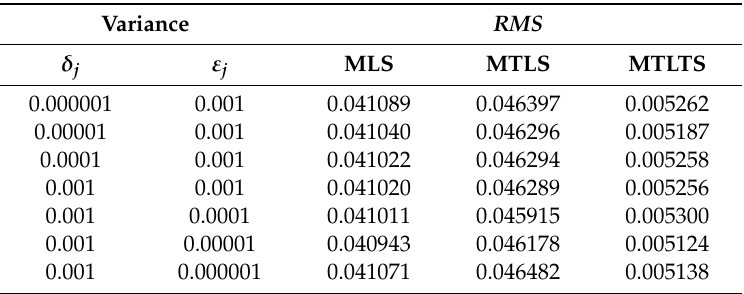
Table 2. The fitting results by three methods in Case 1.